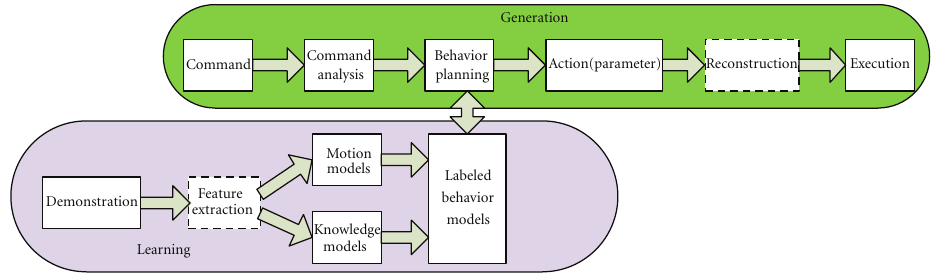
Figure 1: Proposed framework for imitation